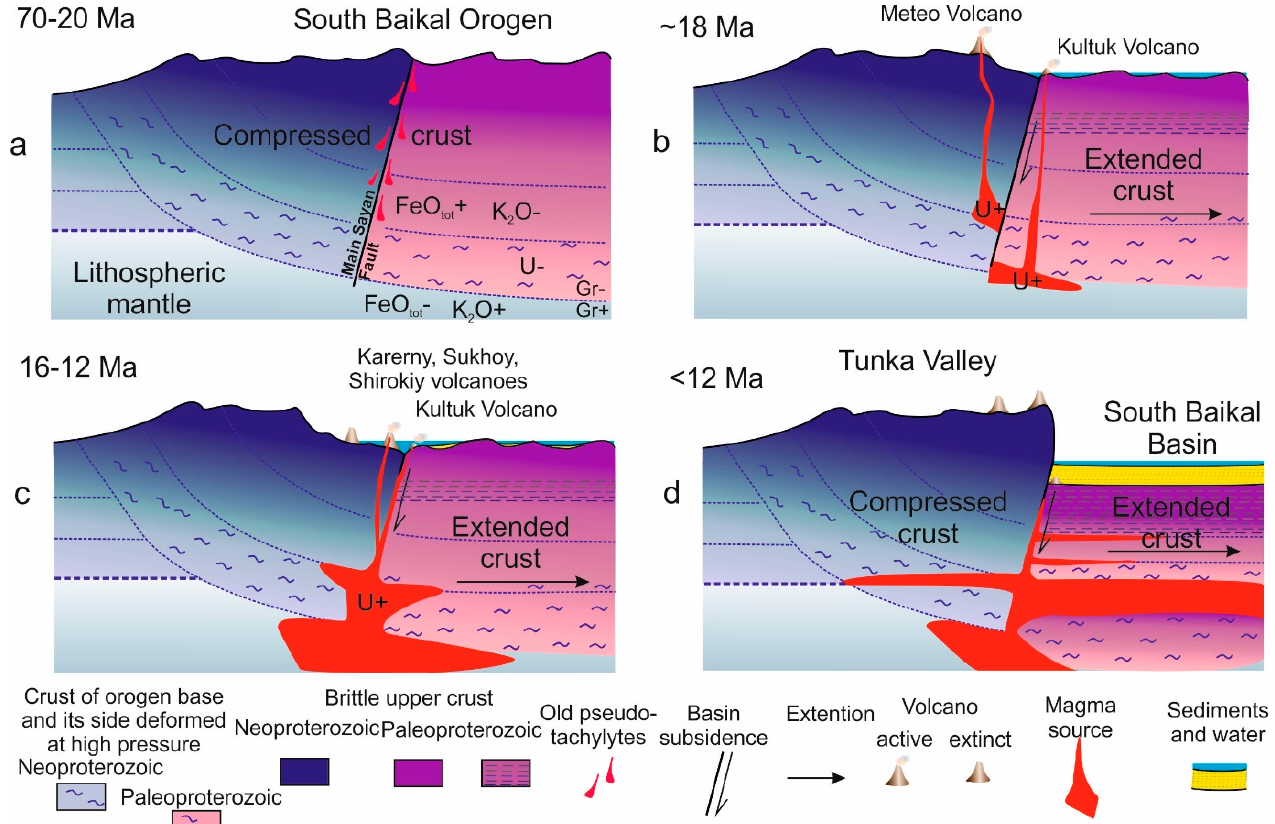
Figure 18. Generation of the CMT melts and volcanic eruptions before contrast vertical tectonic motions at the junction between the South Baikal Basin and Tunka Valley (explanations in the text).